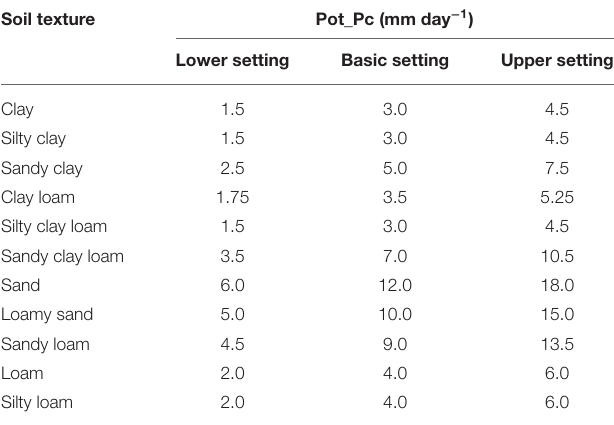
TABLE 3 | Potential percolation rate (Pot_Pc) for rice soil related to soil texture. Soil